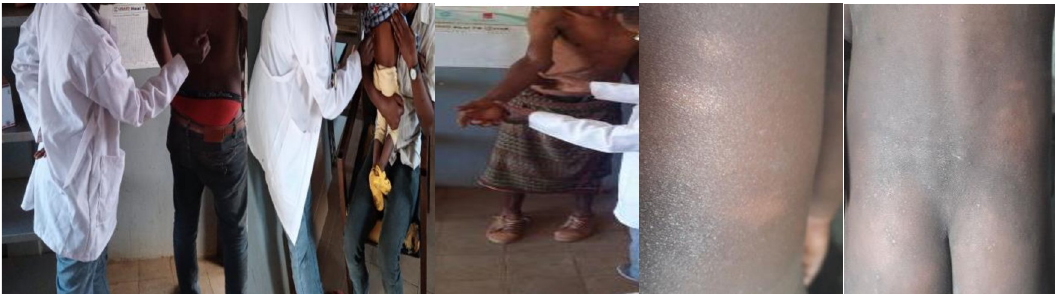
Fig 2. Physical examination of individuals suspected for leprosy based on cardinal signs at leprosy clinic, Fedis district, 2019.